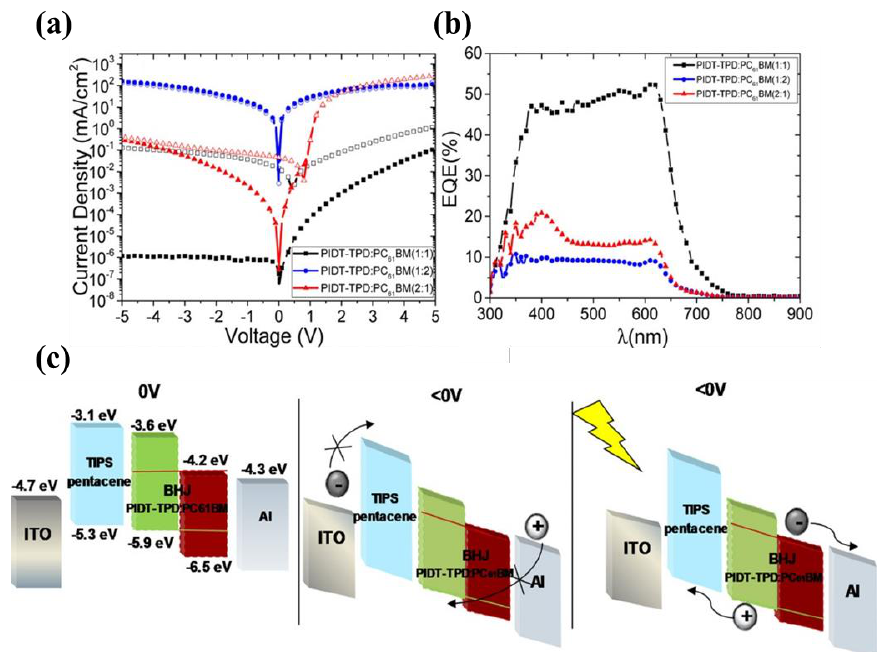
Figure 14. ( a ) J − V characteristics under dark conditions (solid symbols) and under green light at 532 nm at 780 µ W cm − 2 (open symbols) for OPDs comprising different blends ratio; ( b ) EQE of the corresponding devices; ( c ) Energy levels and the working mechanism of the OPD in the dark at 0 V, in the dark at reverse bias, and under illumination at reverse bias. (Reproduced with permission from [122]. ACS Publishing, 2018).